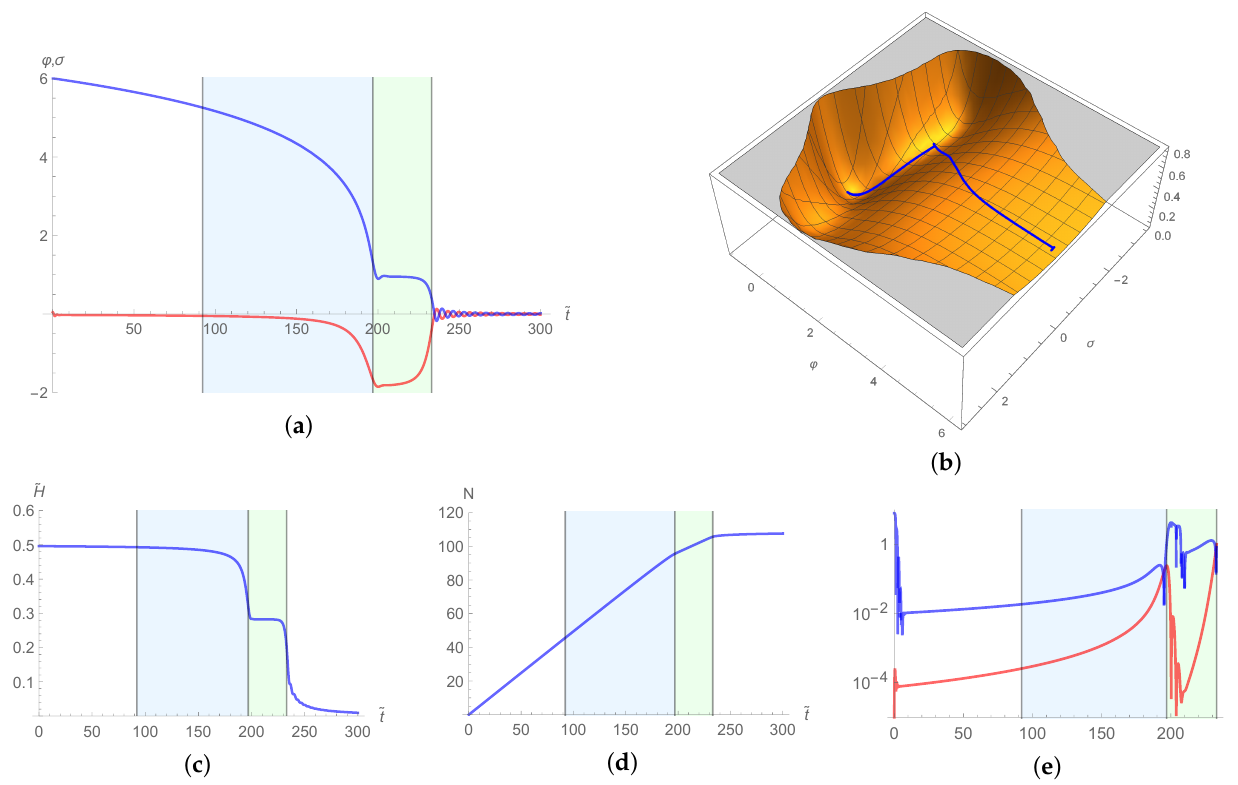
Figure 6. ( a ) The solution to the field Equations (52) and (53) with the initial conditions ϕ ( 0 ) = 6 and σ ( 0 ) = 0.05; the vanishing initial velocities; and the parameter choice γ = 0, δ = 0.1, and ζ = 0.033407. ( b ) The trajectory of the solution ( ϕ —blue; σ —red). ( c ) The Hubble function. ( d ) The e-folds. ( e ) The slow-roll parameters (cid:101) (red) and η (blue).